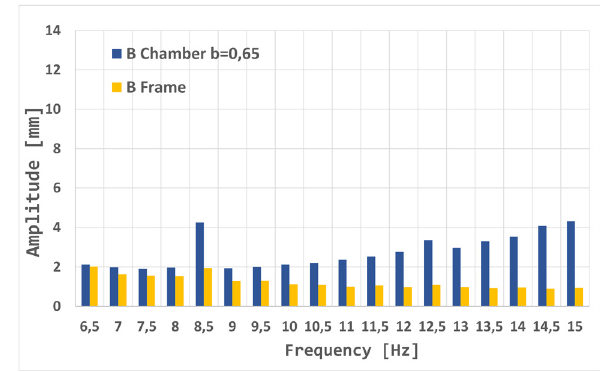
Figure 6: Amplitude – frequency characteristic of the antiresonance mill for the chamber fi lling degree equal to 0.65.